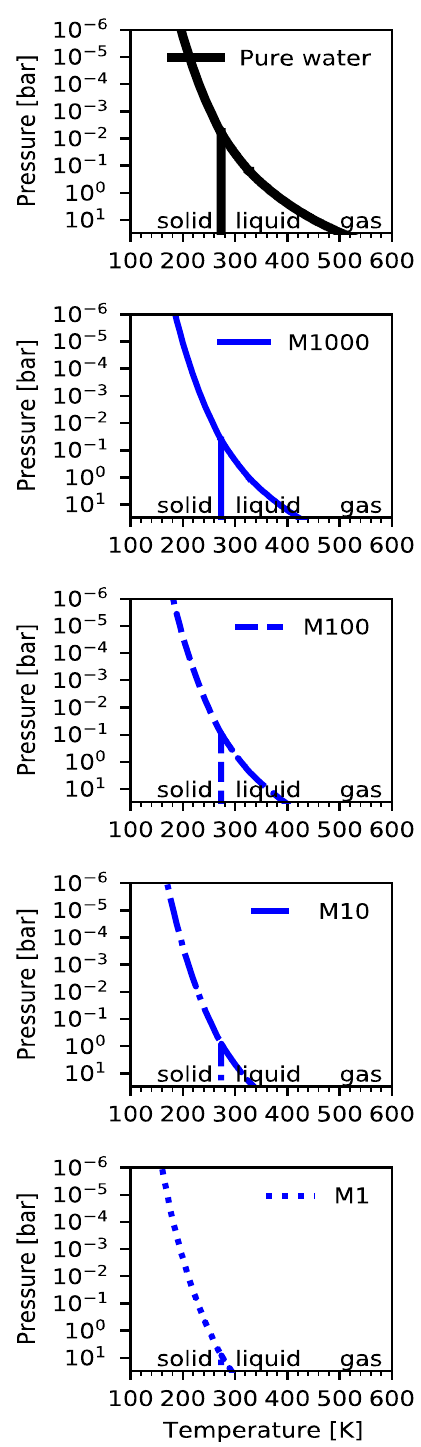
Figure 3. Water equilibrium phase diagram showing condensation curves for varying water content. The x axis shows temperature and the y axis shows pressure. Metallicity values translate to approximate water vapor content in a 90% H 2 and 10% He atmosphere as follows: M1 (solar metallicity) ~ 0.00078; M10 (10× solar) ~ 0.0077; M100 (100× solar) ~ 0.068; M1000 (1000× solar) ~ 0.16. The lines show the condensation curves. The blue-shaded region shows the temperature and pressure range for the liquid water phase. The series of plots shows that, for a fixed temperature, and compared to the pure water phase case, water condenses at lower pressures for lower water content. The pressure for which water can be in liquid phase changes for differing atmospheric total water content.